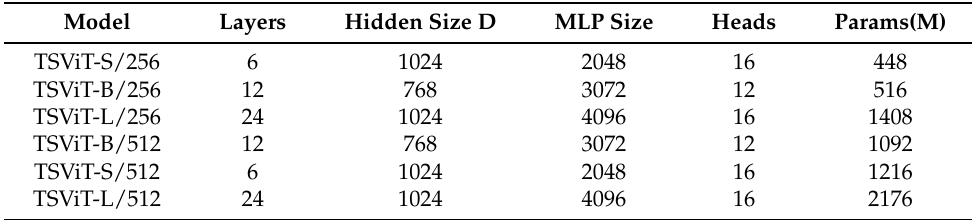
Table 3. Performance comparison of the proposed end-to-end TSViT-based tailing detection frameworks. Model Params (M) Accuracy (%) Precision